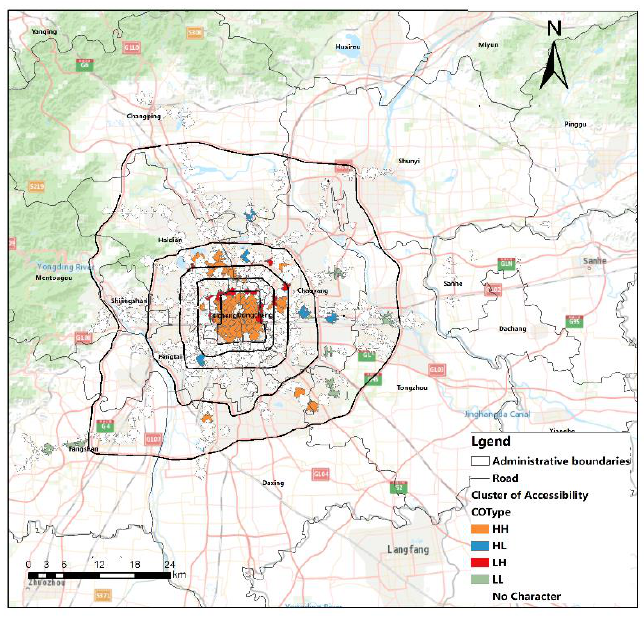
Figure 6. Regional spatial aggregation of rail transit station area accessibility in Beijing.